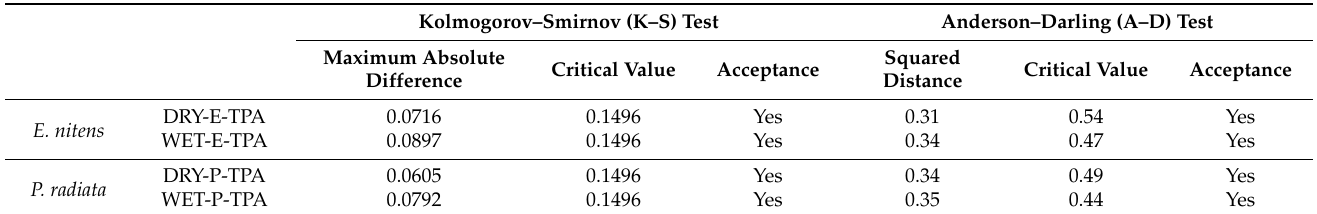
Table 2. Goodness-of-fit for normal distribution of the longitudinal tensile failure strength.